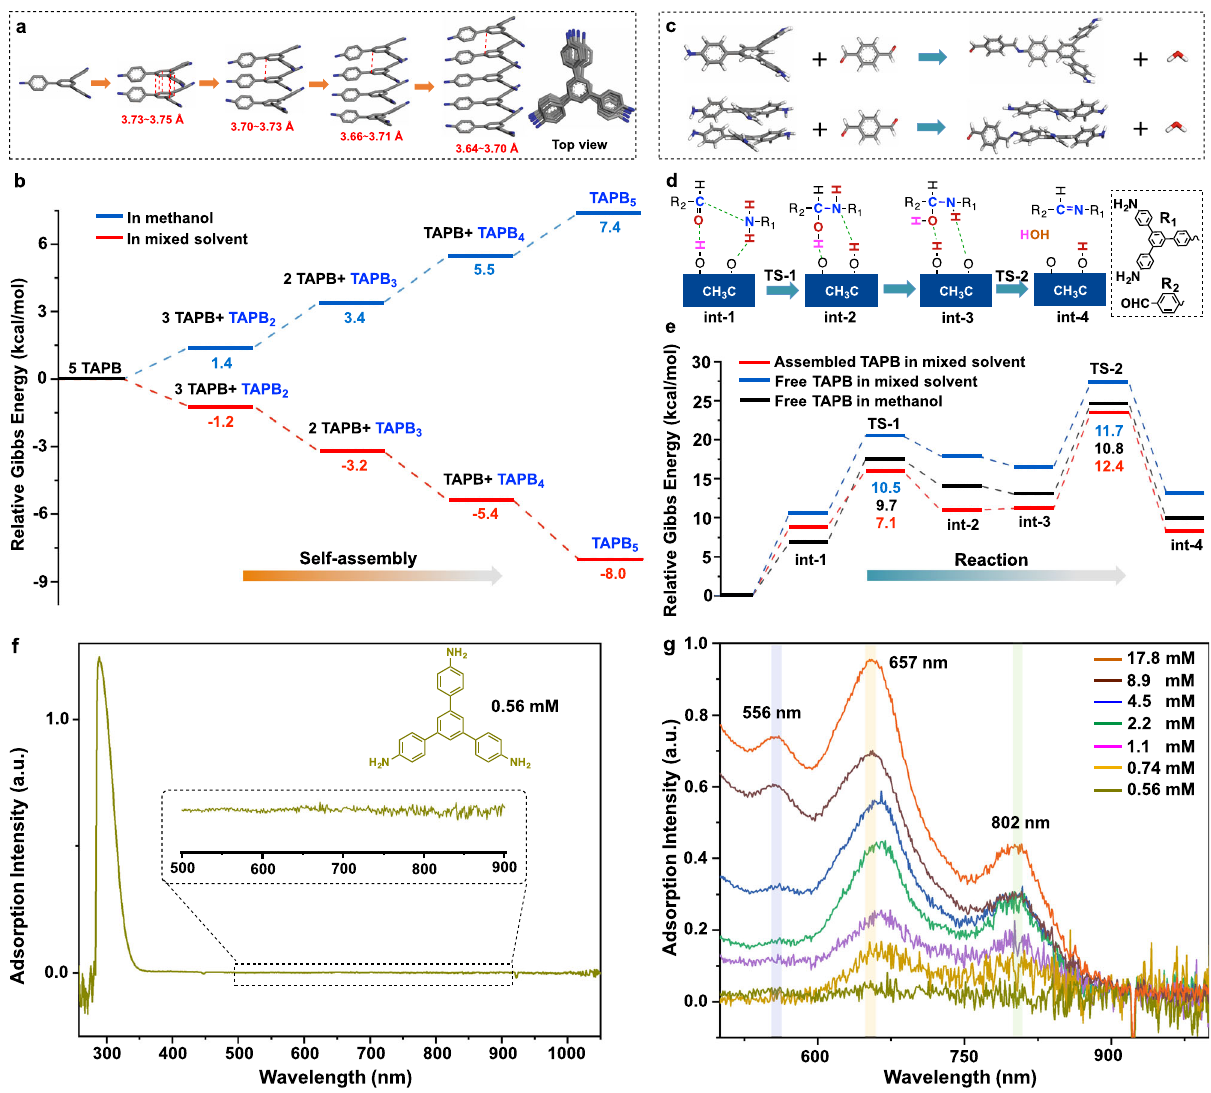
Fig. 2 Self-assembly and Schiff-base condensation of TAPB monomer. DFT calculations on the Self-assembly and Schiff-base condensation of TAPB monomer: a DFT-calculated assembly structures of TAPB. b Gibbs energy variation during the self-assembly of TAPB in methanol versus 1,4-dioxane/ mesitylene. c Reactions between TAPB and its stacked structure with TA. d Proposed Schiff-base formation mechanism between TAPB and TA. e Gibbs energy variation during the reactions of TAPB and its assembled structures with TA in methanol versus 1,4-dioxane/mesitylene. f UV-Vis spectrum of TAPB with a concentration of 0.56 mM in TAPB-TA COF growth solution. g UV-Vis spectra of TAPB with different concentrations in TAPB-TA COF growth solution. The UV-Vis adsorption intensity of each spectrum was normalized according to